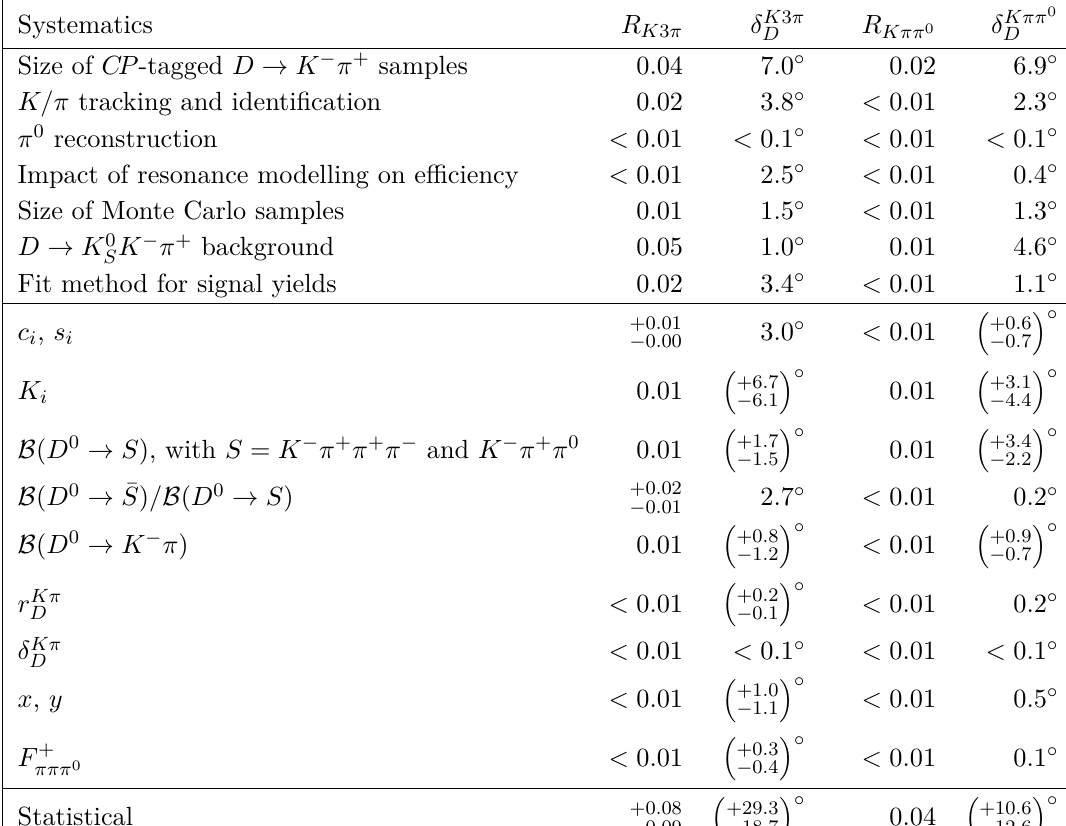
Table 12 . Indicative sizes of the systematics uncertainties on the global hadronic